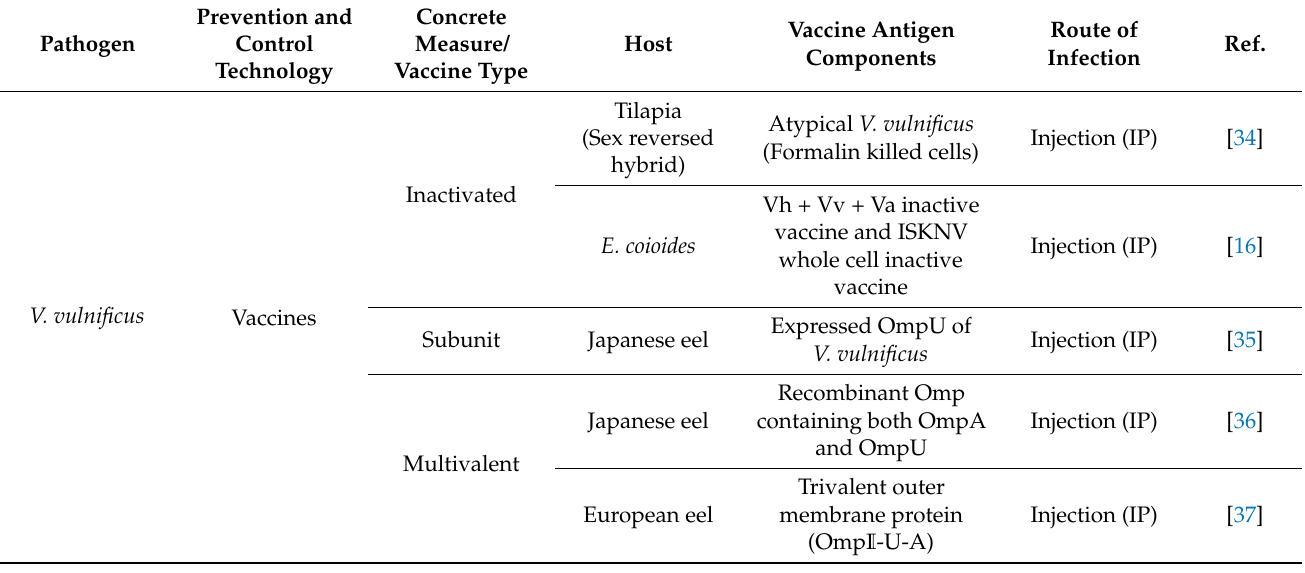
Table 2. Control and prevention strategies of V. vulnificus. NR: Not